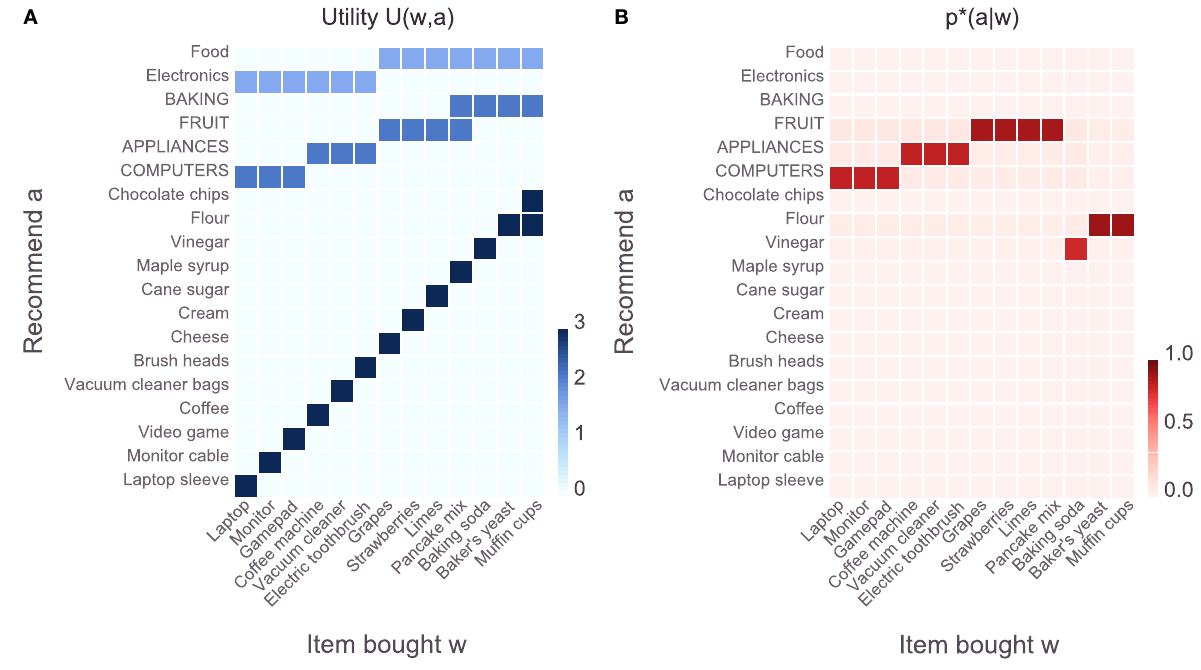
FIGURE 2 | Task setup and solution p *( a | w ) for (cid:12)(cid:12)(cid:12) === 1.3 . (A) Utility function U ( w , a ) for the recommender system task. The recommender system observes an item w bought by a customer and recommends another item a to buy to the customer. For each item bought there is another concrete item that has a high chance of being bought by the customer. Therefore, recommending the correct concrete item leads to the maximum utility of 3. However, each item also belongs to a category (indicated by capital letters) and recommending the best-selling item of the corresponding category leads to a utility of 2.2. Finally, each item also belongs to a super-category (either “food” or “electronics”) and recommending the best-selling item of the corresponding super-category leads to a utility of 1.6. There is one item (muffin cups) where two concrete items can be recommended and both yield maximum utility. Additionally there is one item (pancake mix) where the recommendation of the best-selling item of both categories “fruit” and “baking” yields the same utility. (B) Solution p *( a | w ) [equation (9)] for (cid:12) = 1.3. Due to the low (cid:12) , the computational resources of the recommender system are quite limited and it cannot recommend the highest scoring items (except in the last three columns). Instead, it saves computational effort by applying the same policy to multiple